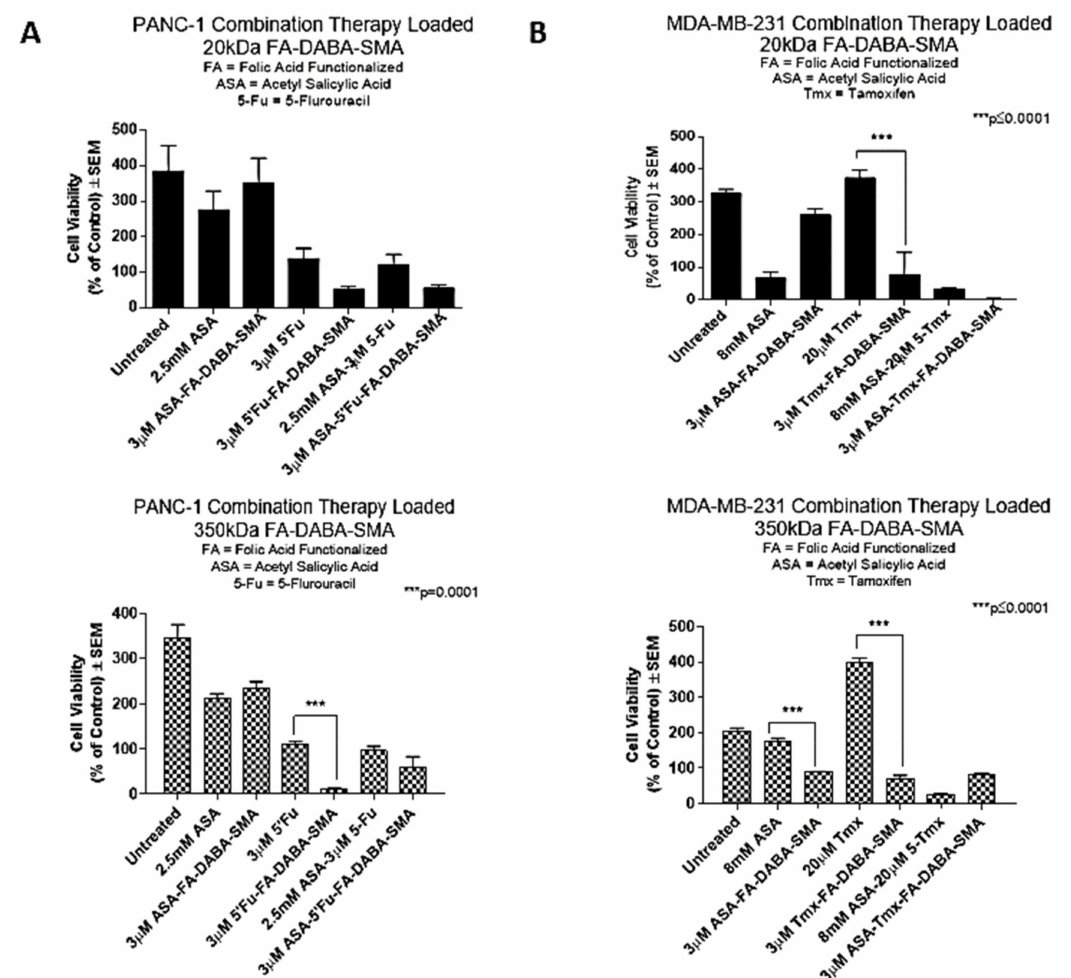
Figure 4. Large nanopolymers deliver hydrophobic therapeutic agents and reduces cell viability more e ffi ciently than small nanopolymers. Comparison of the cell viability of ( A ) PANC-1 and ( B ) MDA-MB-231 cell lines at 72 hours treated with 20 kDa (small) and 350 kDa (large) FA-DABA-SMA nanopolymer loaded with hydrophobic agents, acetylsalicylic acid (ASA), 5-fluorouracil (5-Fu), and tamoxifen (Tmx) given individually or in combination using the WST-1 cell proliferation assay. Results were compared by a one-way ANOVA at 95% confidence using Fisher’s LSD test ( n = 6). The data are a combination of two independent experiments with similar results. The significance is in comparison to the nanopolymer delivered drug(s) and drug alone at the respective time